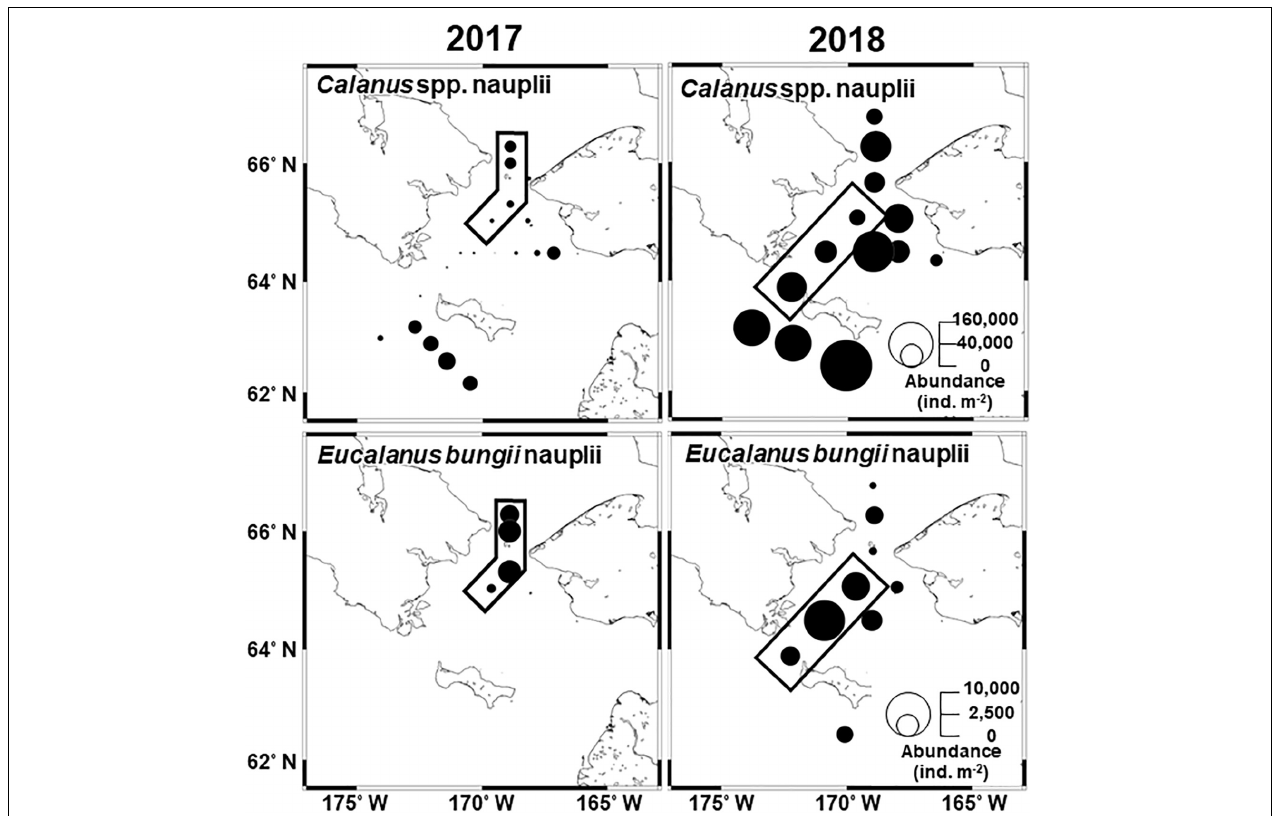
FIGURE 8 | Horizontal distribution of dominant large copepod nauplii in the northern Bering Sea during July 2017 (left) and 2018 (right) . The circle size denotes the abundance of each species. Black frames indicate the stations identified as group E, as demonstrated by Bray–Curtis similarity analyses based on zooplankton abundance (cf. Figure 4